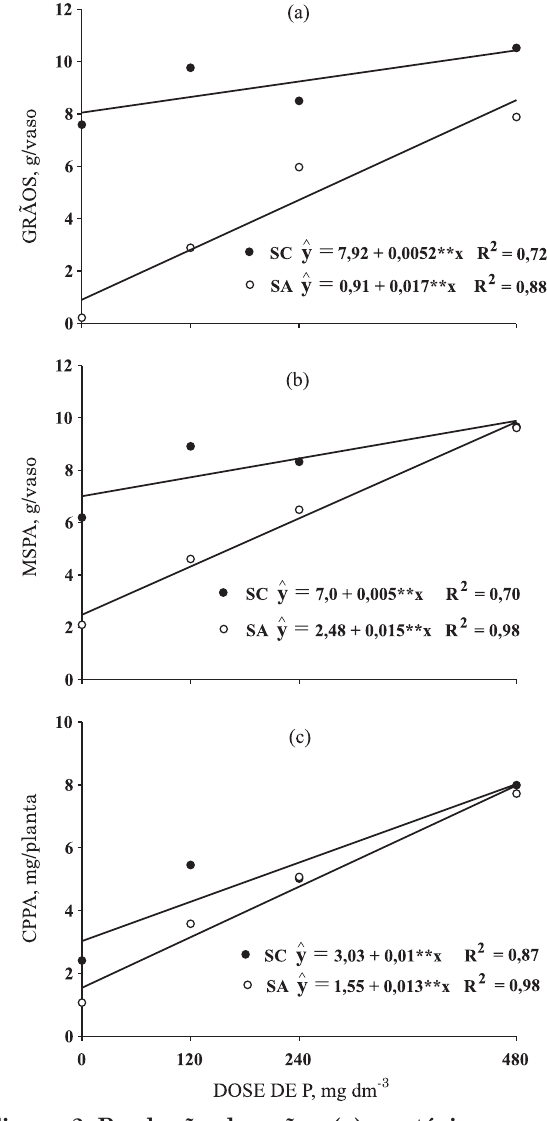
Figura 2. Produção de grãos (a), matéria seca da parte aérea (b) e conteúdo de P na parte aérea no florescimento (c) do feijoeiro em função das doses de fósforo num Latossolo Vermelho, na área de solo cultivada (SC) e solo adjacente (SA).